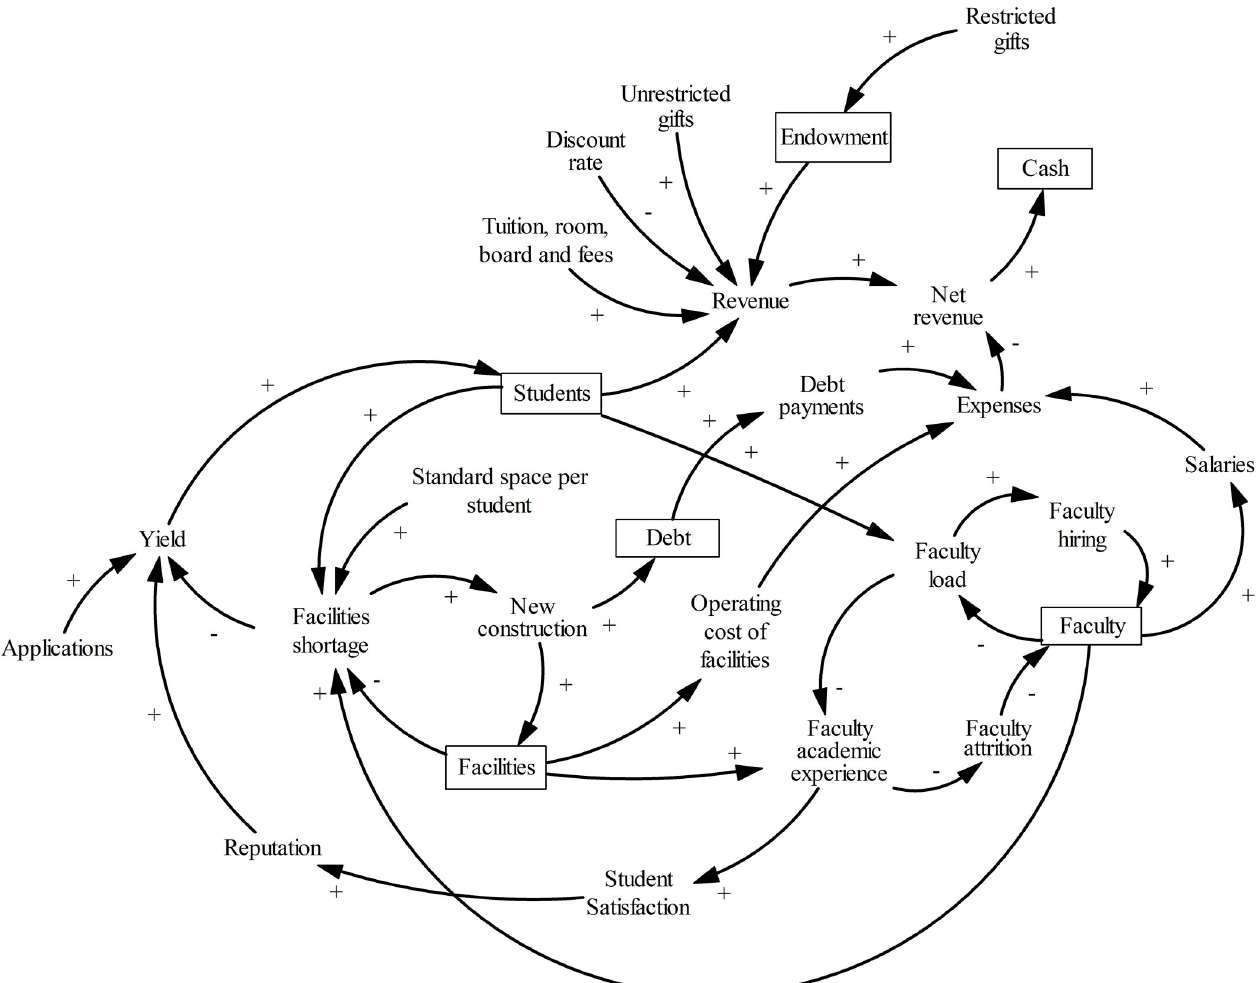
Fig 7. Causal structure of the college model . The model has six stocks, shown as rectangles.